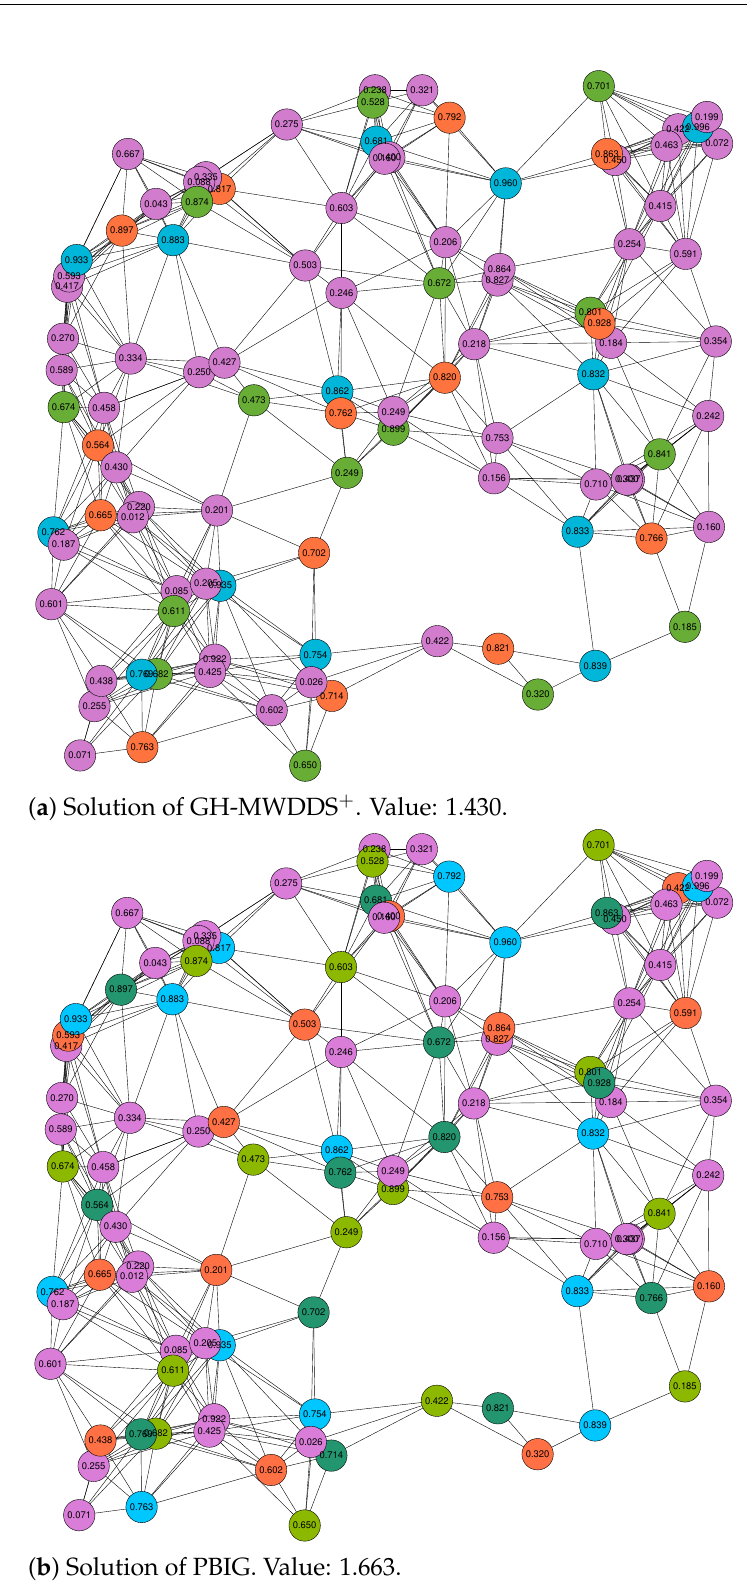
Figure 2. Solutions of GH-MWDDS + ( a ) and PBIG ( b ) for the first RGG graph with 100 nodes and a threshold value of r = 0.2. The lifetime of each node is provided as the node label. Moreover, the node colors indicate to which dominating set a node belongs. In both cases, the color purple indicates that the respective node is not chosen for a dominating